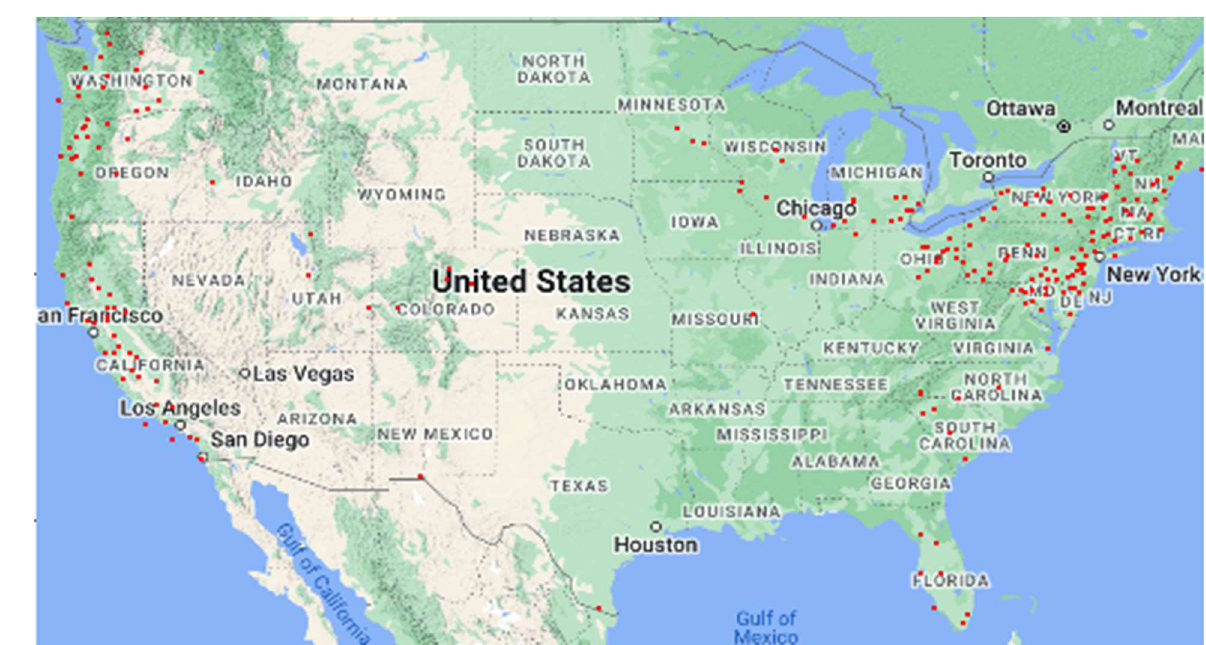
Figure 6. Cluster 4 (690 counties from 37 different states).